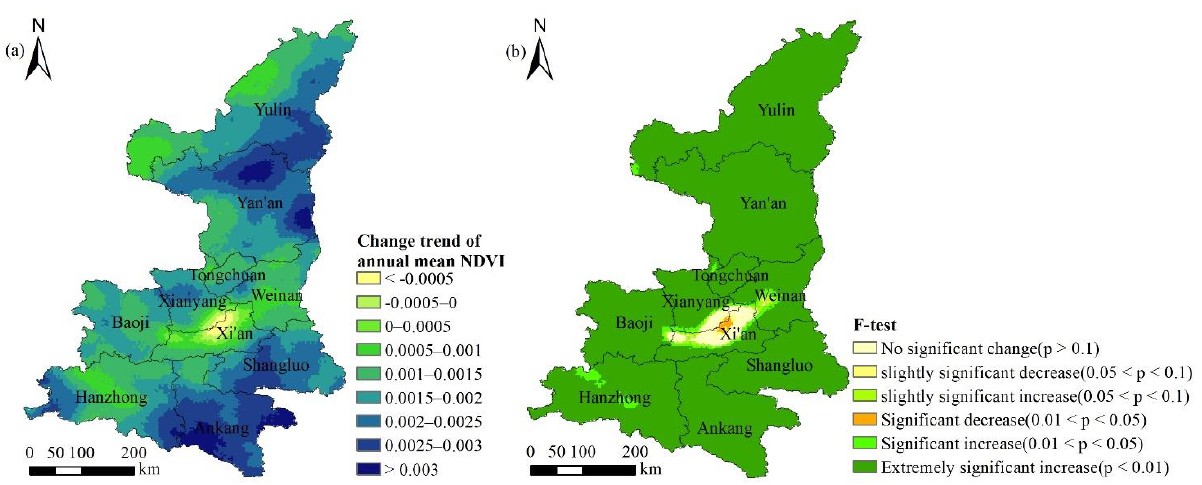
Figure 7. Spatial distribution of change trend of annual mean NDVI ( a ) and its significance ( b ) in Shaanxi Province during 1982–2015. Table 3. Pixel numbers and proportion of change trend of the NDVI in Shaanxi province